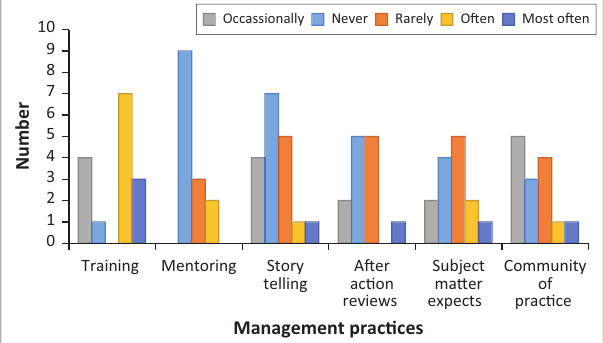
FIGURE 2: Management practices for tacit knowledge